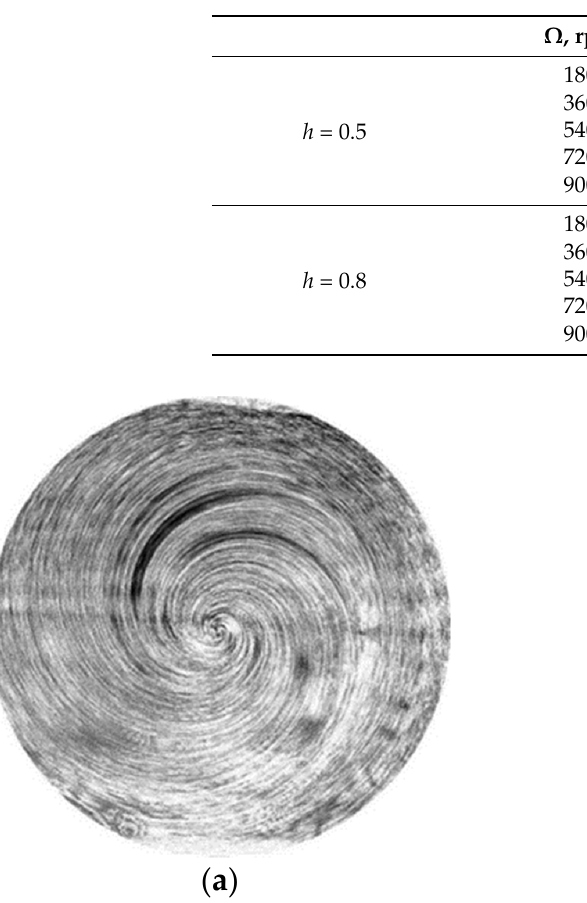
Figure 4. Visualization of the motion of the model fluid: ( a ) the flow diverging from the axis below the interface and ( b ) the flow converging to the axis near the bottom at Ω = 900 rpm, h g = 0.5 h .